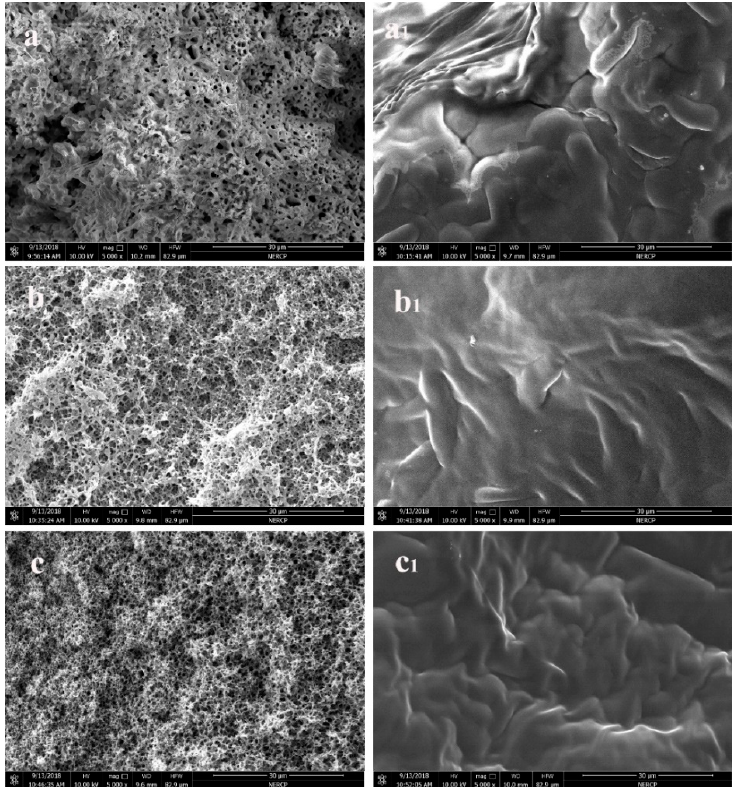
Figure 3. Encapsulation effect of membrane wall Cross-section; ( a ) is PVDF membrane; ( b ) is PP membrane; ( c ) is PSF membrane; ( a ), ( b ), ( c ) are before paraffin encapsulation; ( a 1 ), ( b 1 ), ( c 1 ) are after paraffin encapsulation.